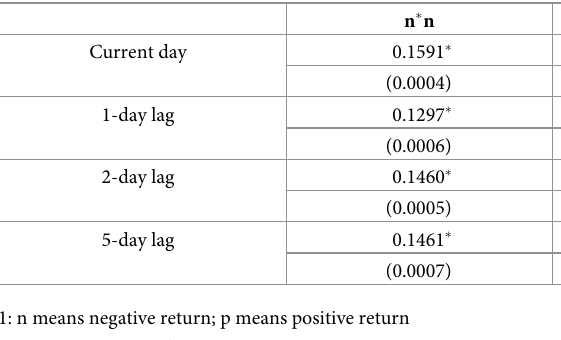
Table 5. Tail dependence test result for CCX and EU